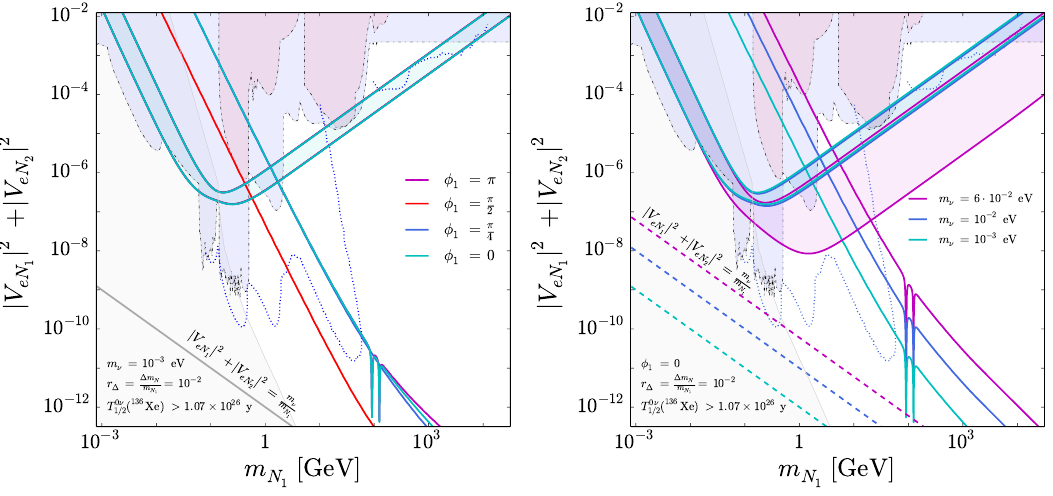
Figure 11 . Upper limits on the sum of squared active-sterile mixing for the sterile neutrino mass splitting ratio r (cid:1) = (cid:1) m N = 10 (cid:0) 2 derived from 0 (cid:23)(cid:12)(cid:12) decay and loop constraints. We show the m N 1 limits from 136 Xe for di(cid:11)erent values of (cid:30) 1 (left) and m (cid:23)